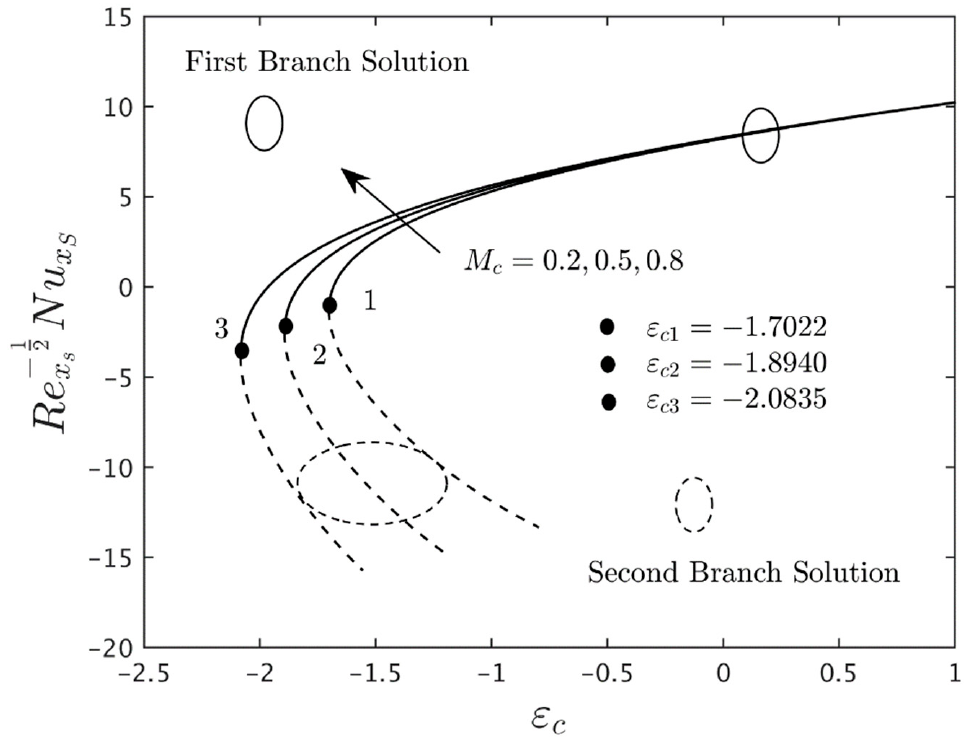
for the several values of c